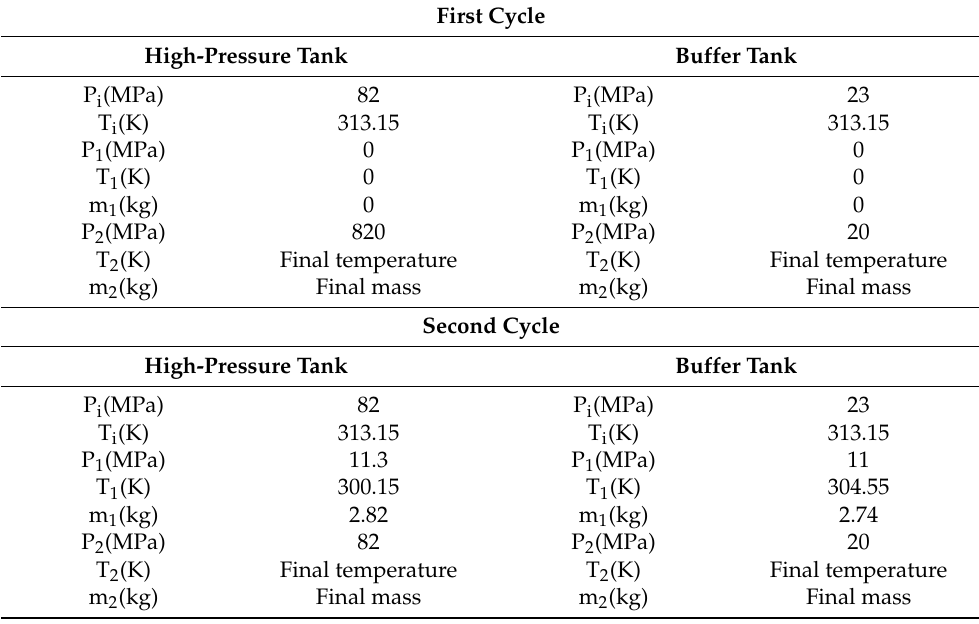
Table 4. Initial data of cycle system of the hydrogen storage tanks.